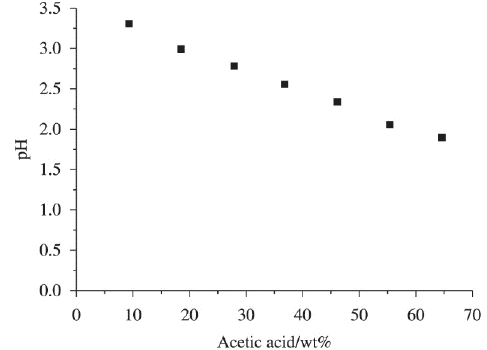
Figure 2. pH as a function of acetic acid concentration.